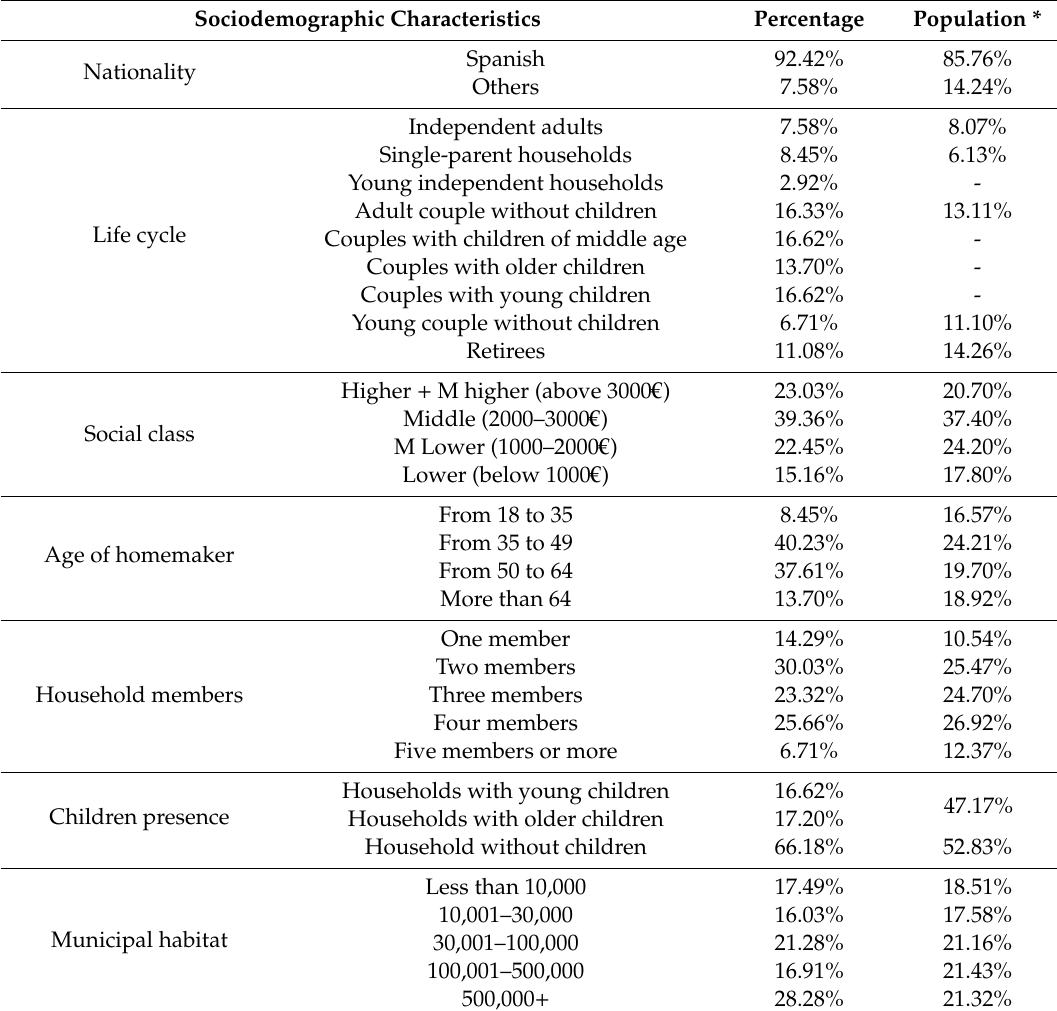
Table 1. Sociodemographic characteristics of the